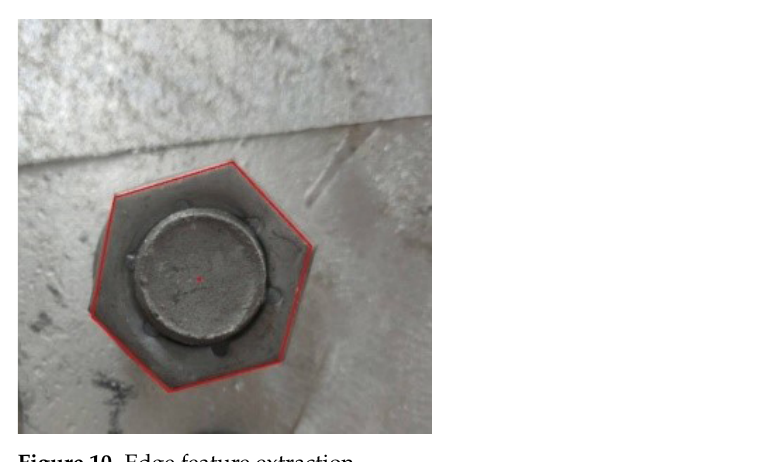
Figure 10. Edge feature extraction.